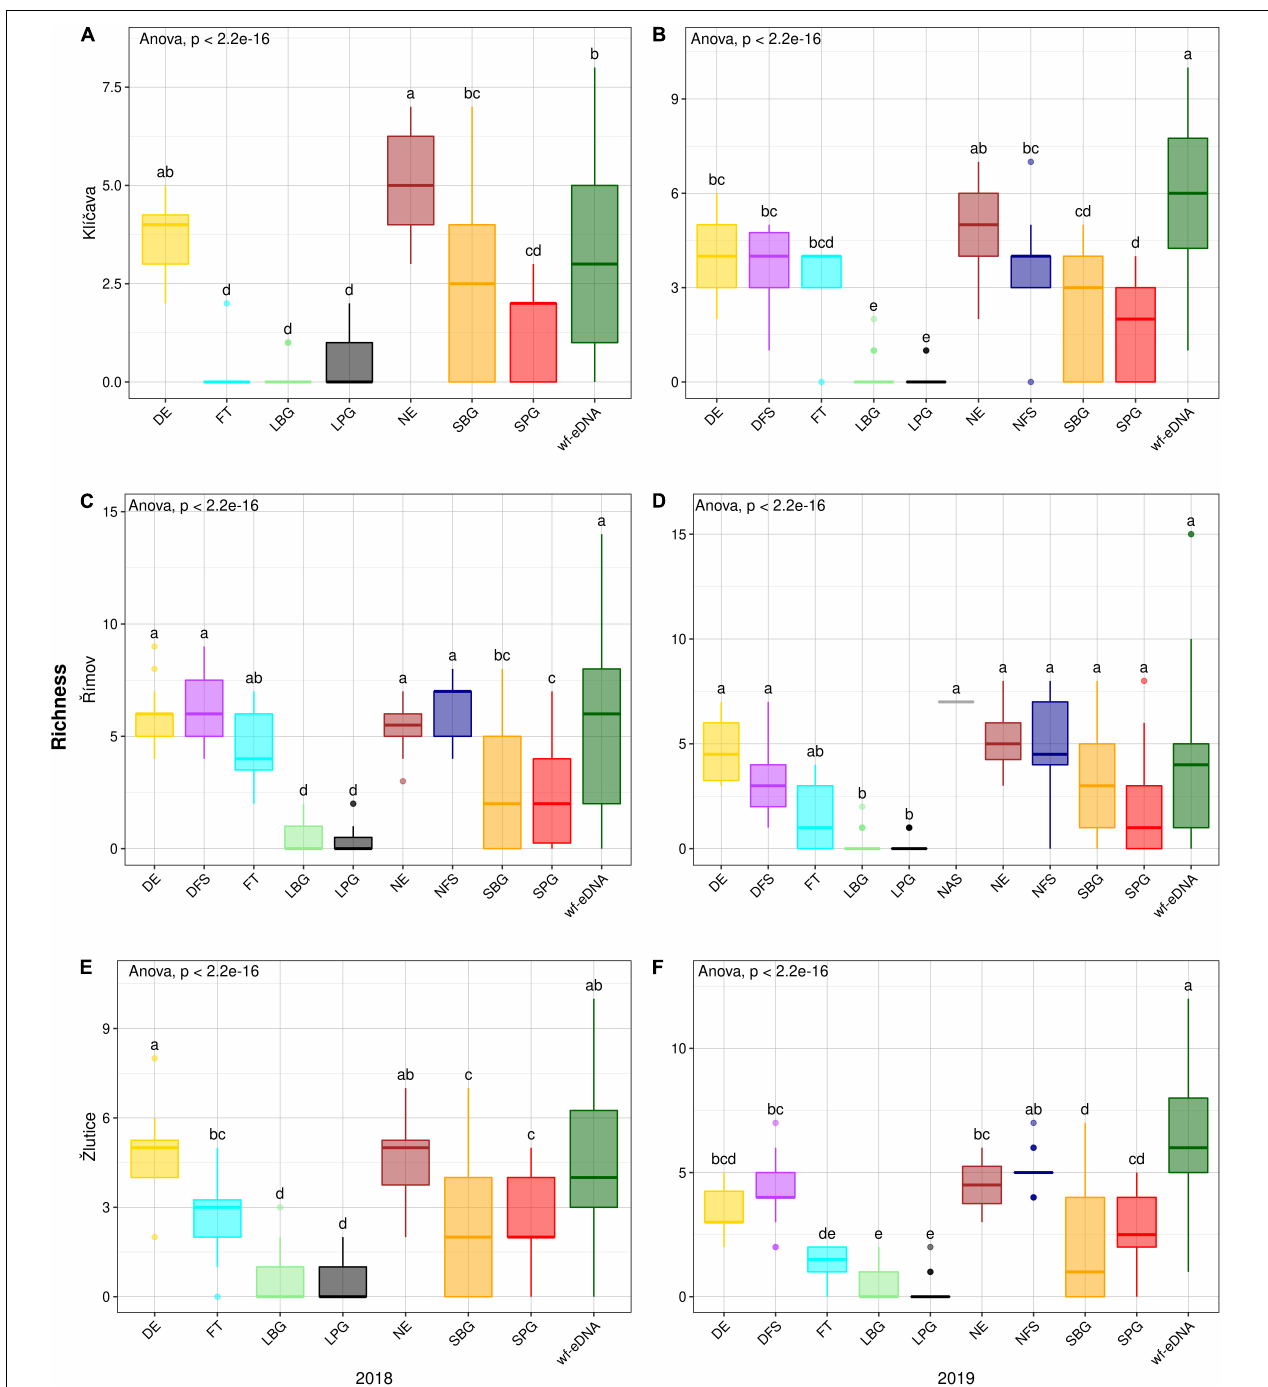
FIGURE 6 | Box plots comparison of alpha diversity (Richness) based on CPUE data in 2018 (left plots) and 2019 (right plots) between wf-eDNA assay and traditional sampling methods in Klíˇcava, ˇRímov and Žlutice reservoirs. Significant differences are indicated by different superscripts. The horizontal line inside the box indicates the calculated median, box 1st and 3rd quartile, whiskers data range and dots outliers of Richness value. Traditional sampling methods are abbreviated as follow: DE = day electrofishing, NE = night electrofishing, SBG = standard benthic gillnets, SPG = standard pelagic gillnets, LBG = large mesh-size benthic gillnets, LPG = large mesh-size pelagic gillnets, NAS = night-time adult seining, DFS = day-time fry seining, NFS= night-time fry seining, FT = fry trawl and wf-eDNA = eDNA from water targeting fish.